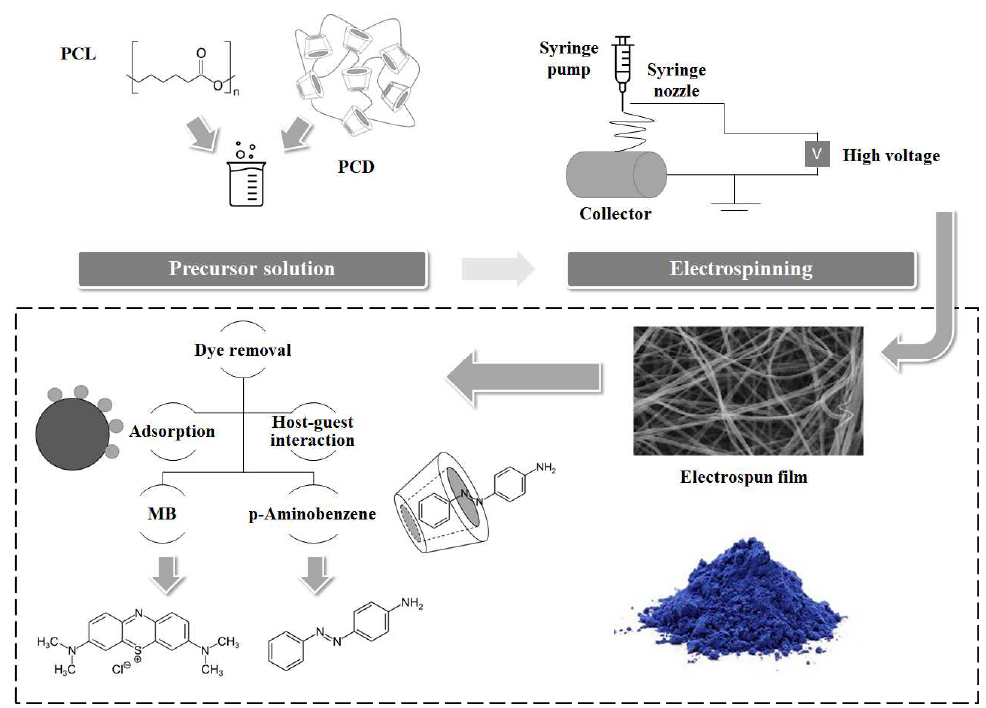
Figure 4. Schematic representation for the synthesis and adsorption mechanism of β-CD/PCL composite fibers for MB [95].